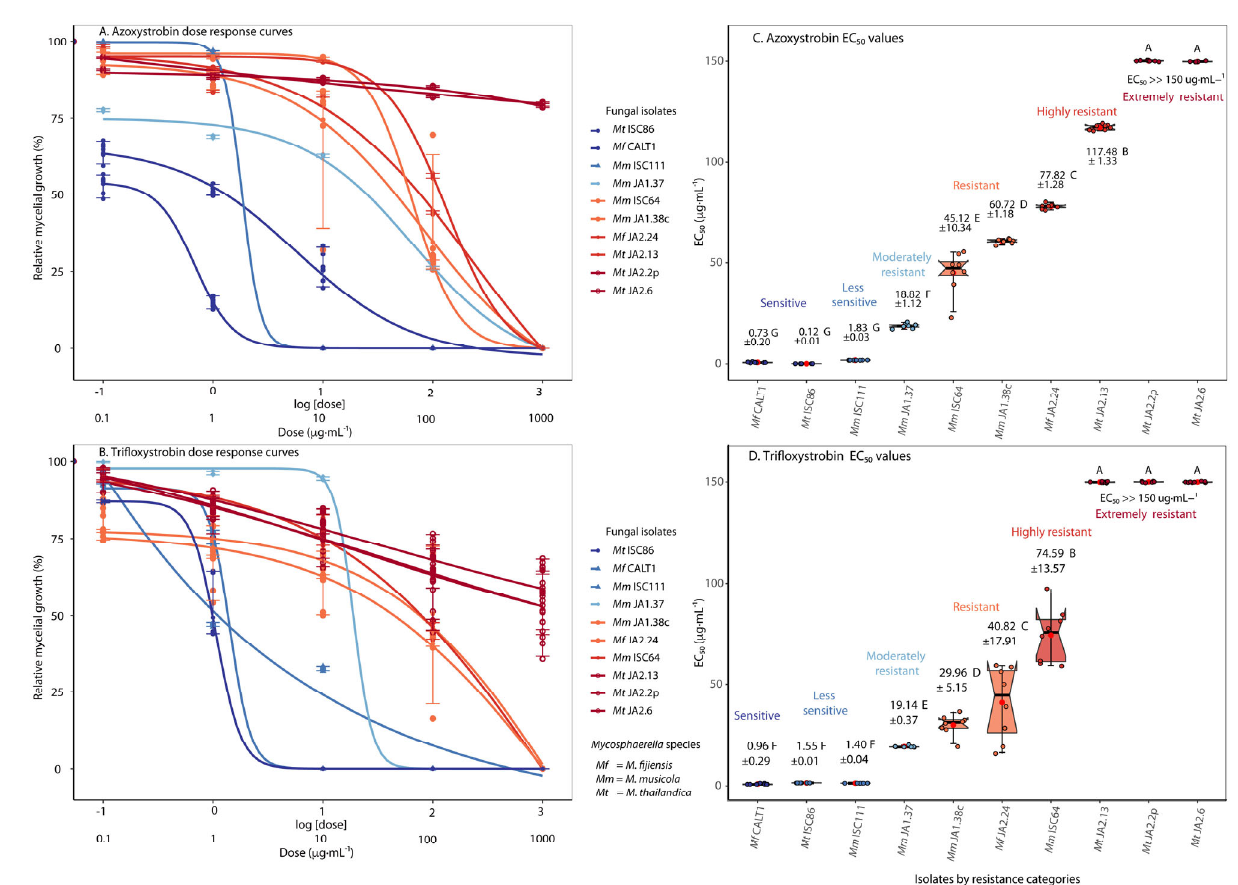
Figure 5. Contrasting in vitro dose–response curves of the relative growth of individual isolates of Mycosphaerella fijiensis (Mf), M. musicola ( Mm ) and M. thailandica ( Mt ) in increasing concentrations of the QoI fungicides azoxystrobin ( A ) and trifloxystrobin ( B ) in PD broth on a resazurin activity microplate assay. Estimates of the isolates’ EC 50 values for azoxystrobin ( C ) and trifloxystrobin ( D ) and corresponding sensitivity and resistance categories a . a F test from ANOVA significant at p ≤ 0.001. Means followed by the same capital letter are not significantly different by the Scott–Knott test at p ≤ 0.05. Analyses of the cytochrome b ( cyt b ) partial gene sequences from Mm , Mf and Mt strains showed the known non-synonymous G143A substitution associated with azoxystrobin and trifloxystrobin resistance (QoI-R) in both species (Tables 4 and 5, Figure 6). Considering M. musicola in particular (Table 4), 87 Mm QoI-sensitive strains (QoI-S), which do not have this mutation were grouped in the cyt b haplotype Hm1, and nine Mm strains (ISC64, ISC55a, ISC09, ISC110, ISC116, ISC117, MG118, JA1.37 and JA1.38c) carrying the G428C mutation leading to the G143A amino acid substitution belongs to the Hm2 . The Mm LFZO01000638.1 cyt b sequence used as reference is also Hm1 . The reference sequence NC037198.1 from Pseudocercospora mori presented 20 substitutions, all of them synonymous mutations ( Hm3 ). Both these reference strains have no QoI-sensitivity information available (Table